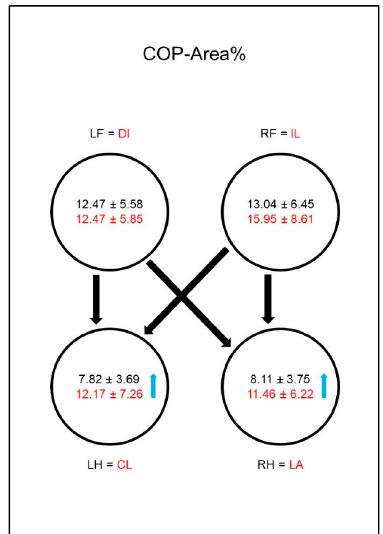
Figure 8. Area encompassed by the boundaries of the center of pressure movement as a percentage of paw contact area (COP-Area%) in study group 1 and control group. For detailed explanation and abbreviations refer to Figure 2.